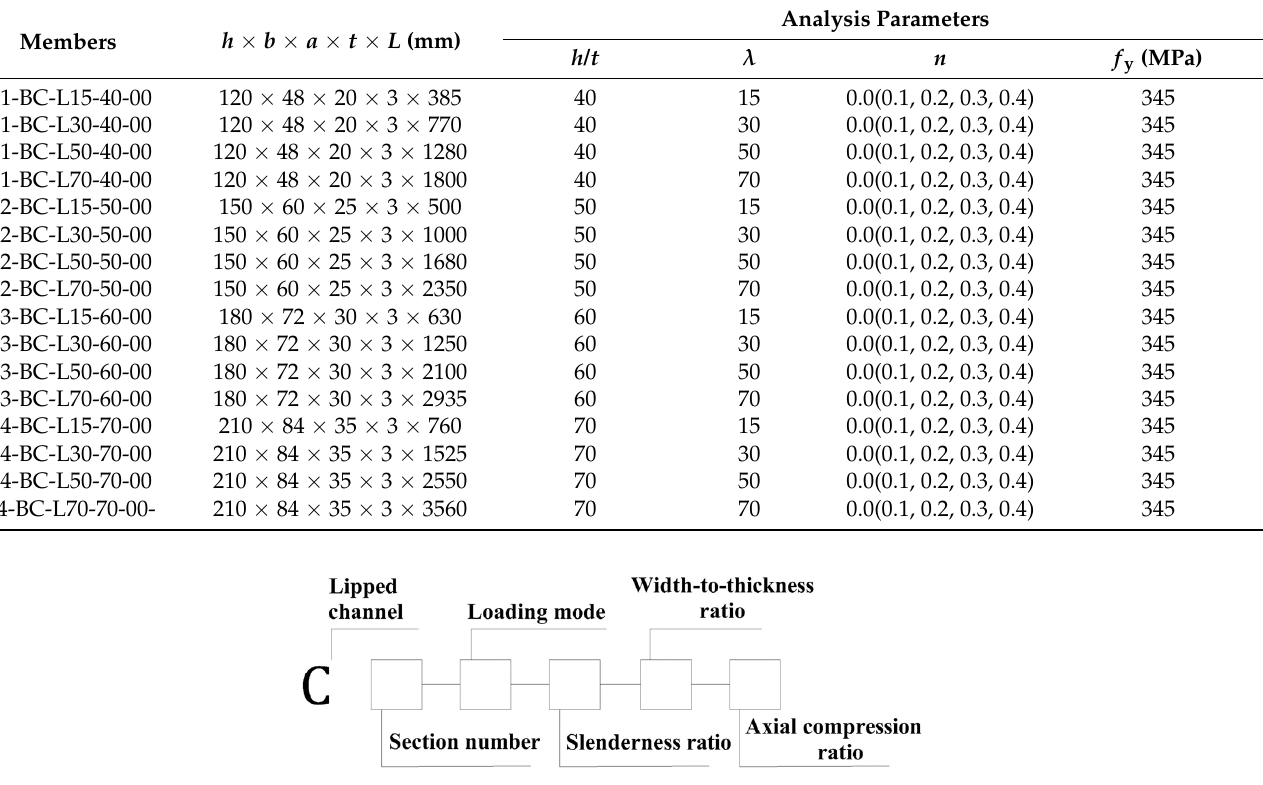
Table 2. Cold-formed thin-wall steel lipped channel beam-column sections for FEA.